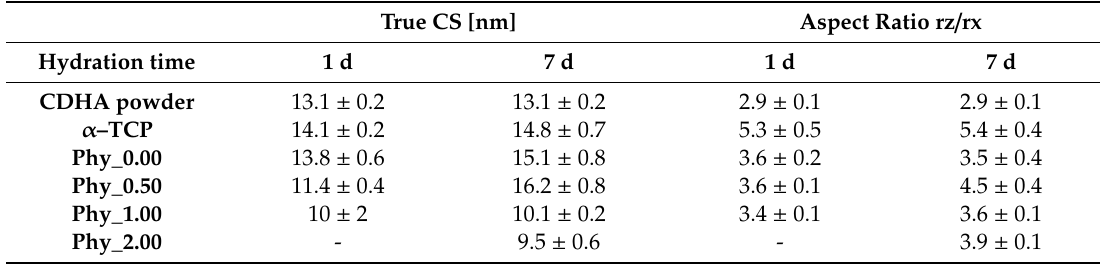
Table 3. True CS and aspect ratio rz / rx of CDHA crystallites in storage samples after 1 d and 7 d of hydration; a 0.2 M Na 2 HPO 4 solution was used as the mixing liquid with an L / P of 0.3 ml / g Powder ; the samples were stored at 37 ◦